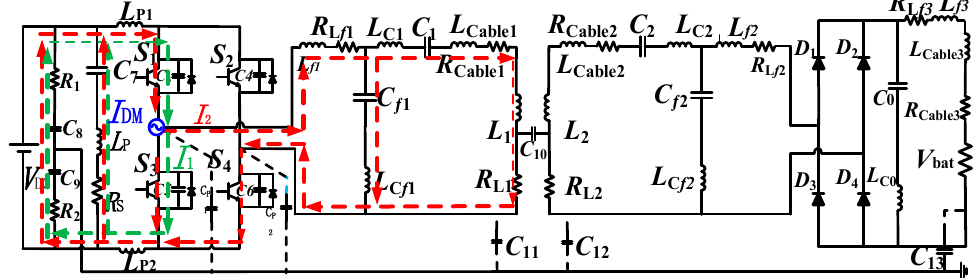
Figure 11. Analysis for DM interference: DM current path.